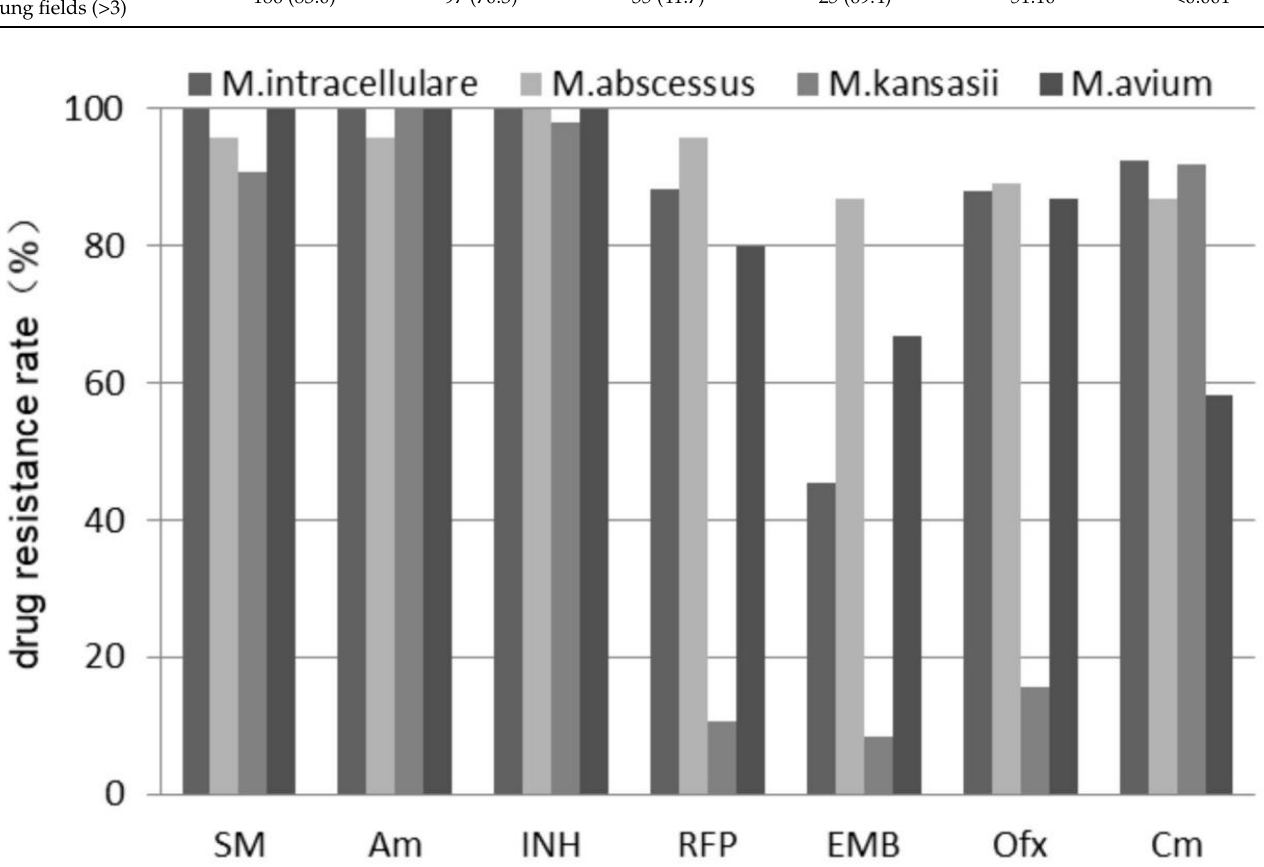
Figure 3. Drug resistance rates of patients in different groups to common anti-tuberculosis drugs.